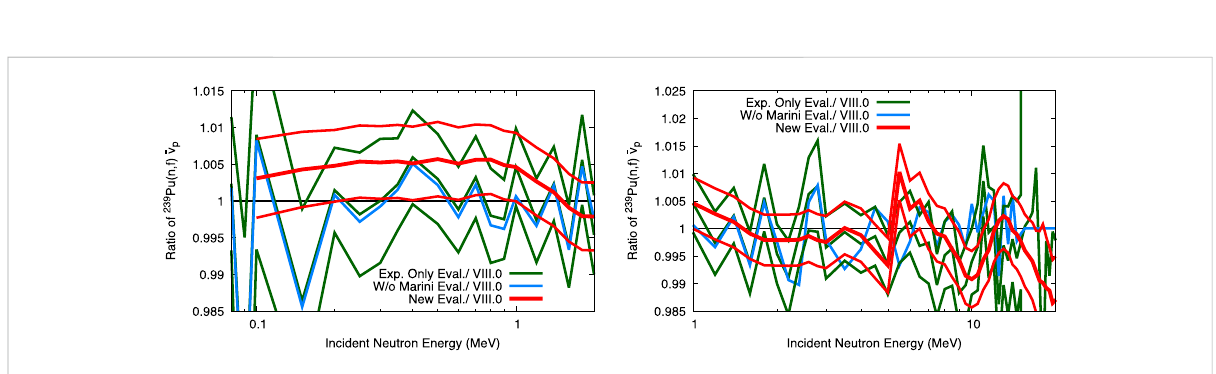
Hence, this small difference up to 14 MeV in the shape of evaluations (2) and (3) indicates that the TPC con fi rms the shape obtained from a bulk of data measured with fi ssion